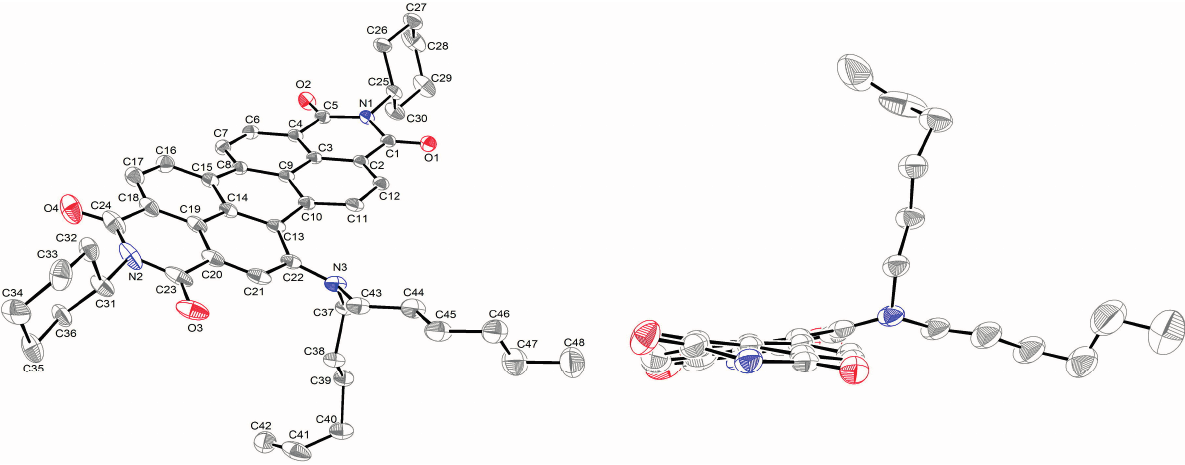
Figure 2. Molecular structure of 2a ( left ) and the view along the N–N axis showing the twisted perylene backbone ( right ) (alkyl groups at imide nitrogen atoms and all hydrogen atoms are omitted for clarity). Displacement ellipsoids are drawn at the 50% probability